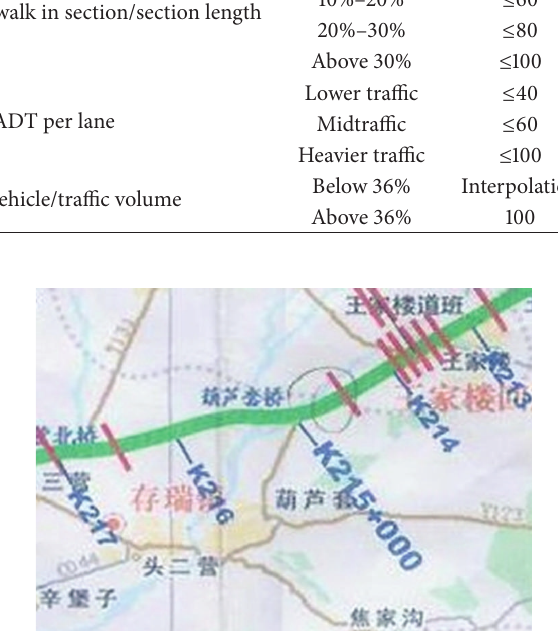
Figure 7: Hebei provincial highway S241